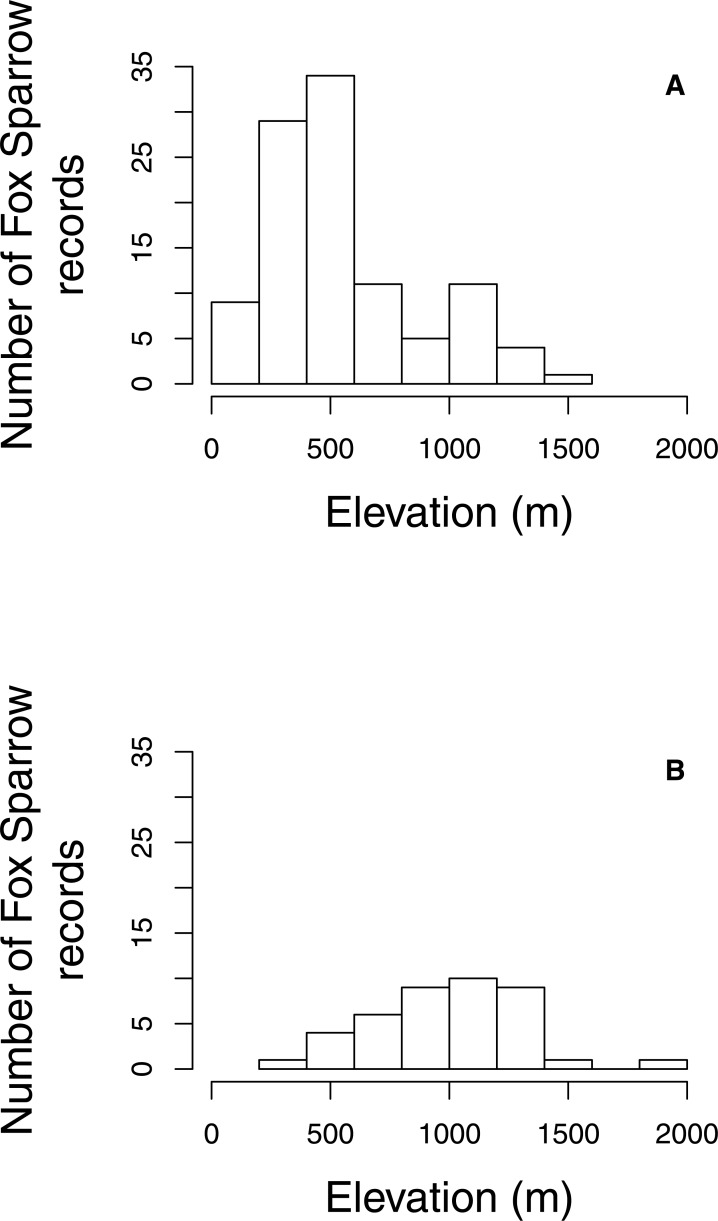
Elevation of Fox Sparrow observations on eBird checklists during June and July in Maine and New Hampshire.Fox Sparrow observations recorded in eBird tended to occur at lower elevations in Maine (A) than in New Hampshire (B).